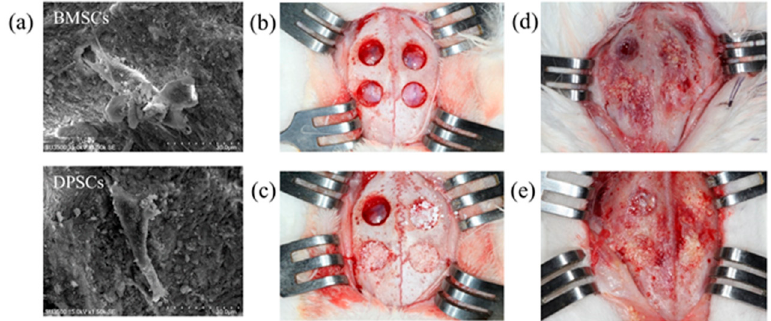
Figure 6. Rabbit calvarial bone defects and microscopic analysis. ( a ) Scanning electron microscopy (SEM) images of BMSCs and DPSCs cultured on Bio-Oss scaffolds. ( b ) Rabbit calvarial bone defects. ( c ) Local transplantation of MSCs combined with Bio-Oss scaffolds. ( d ) Macroscopic view of regenerative areas after 3 weeks of healing. ( e ) Macroscopic view of regenerative areas after 6 weeks of healing.